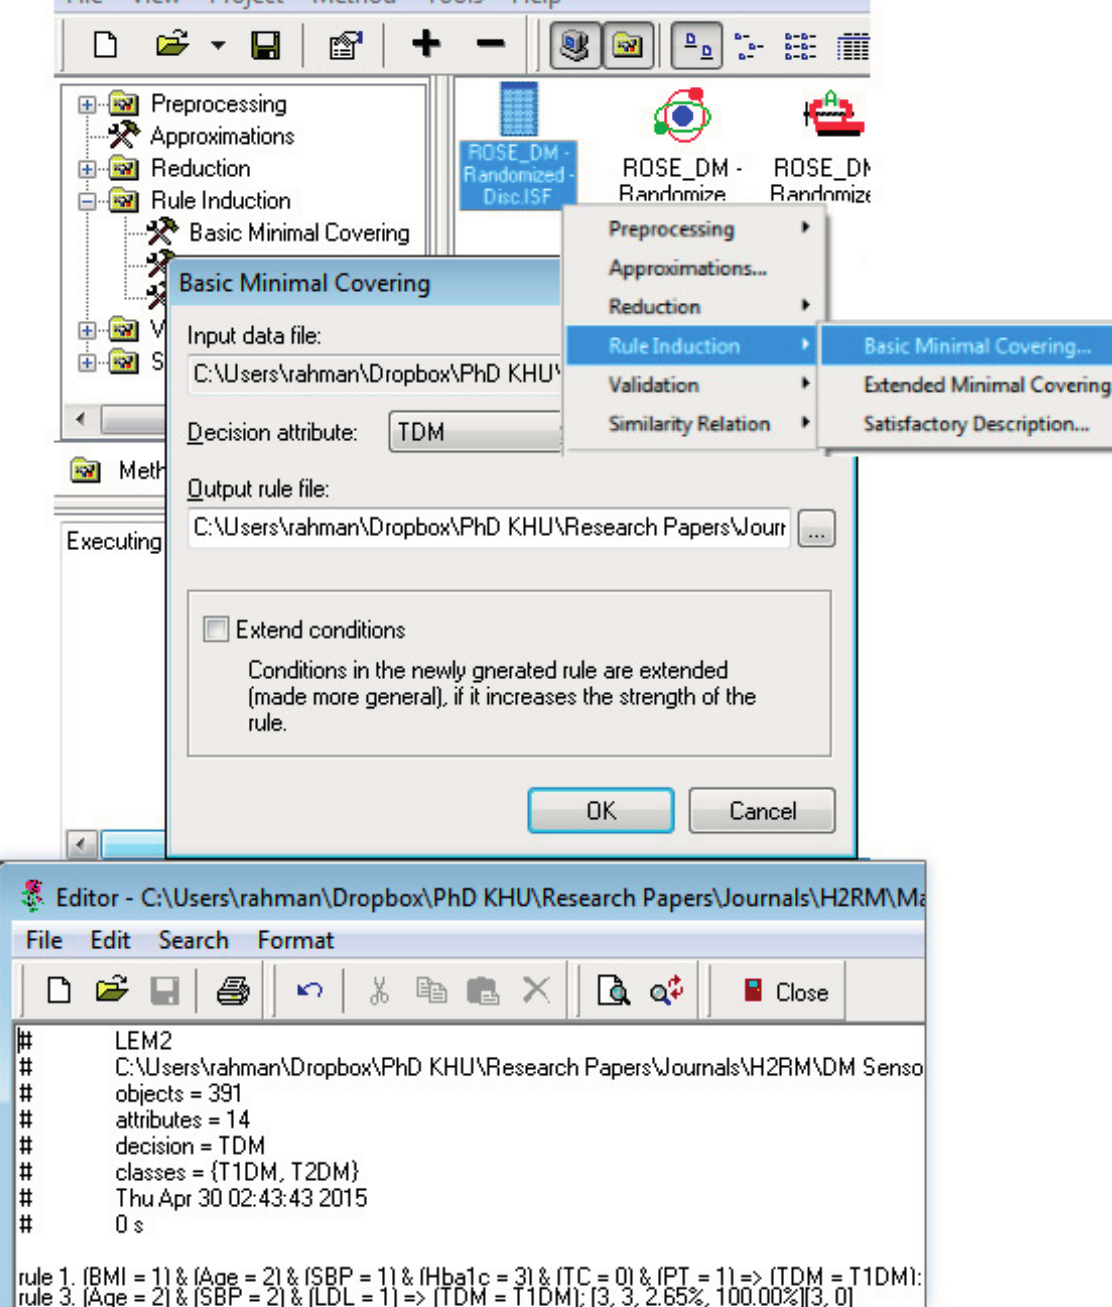
Figure A3. Rules induction setting in rough set data exploration system (ROSE 2) system along with the inducted rules as